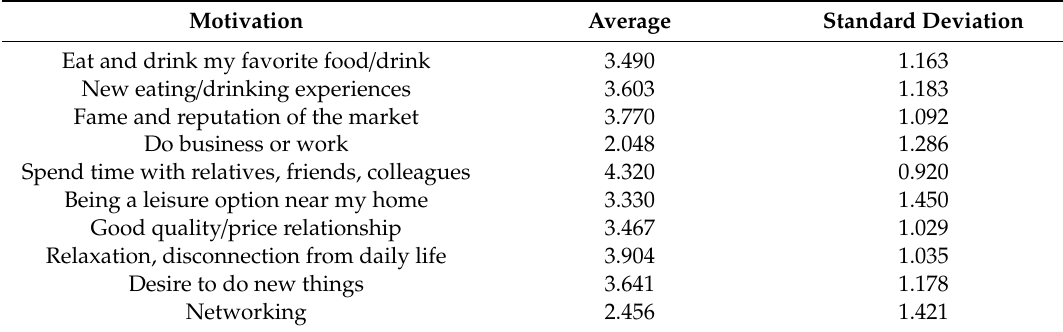
Table 3. Motive for the visit to the food